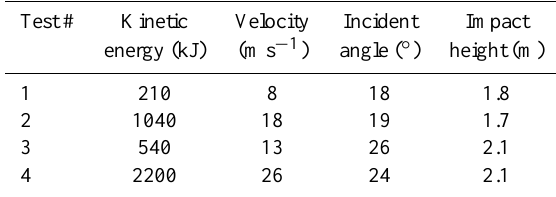
the ground at the kernel–levee interface, based on accelerometer and displacement sensor data (2200kJ impact test). Table 1. Impact